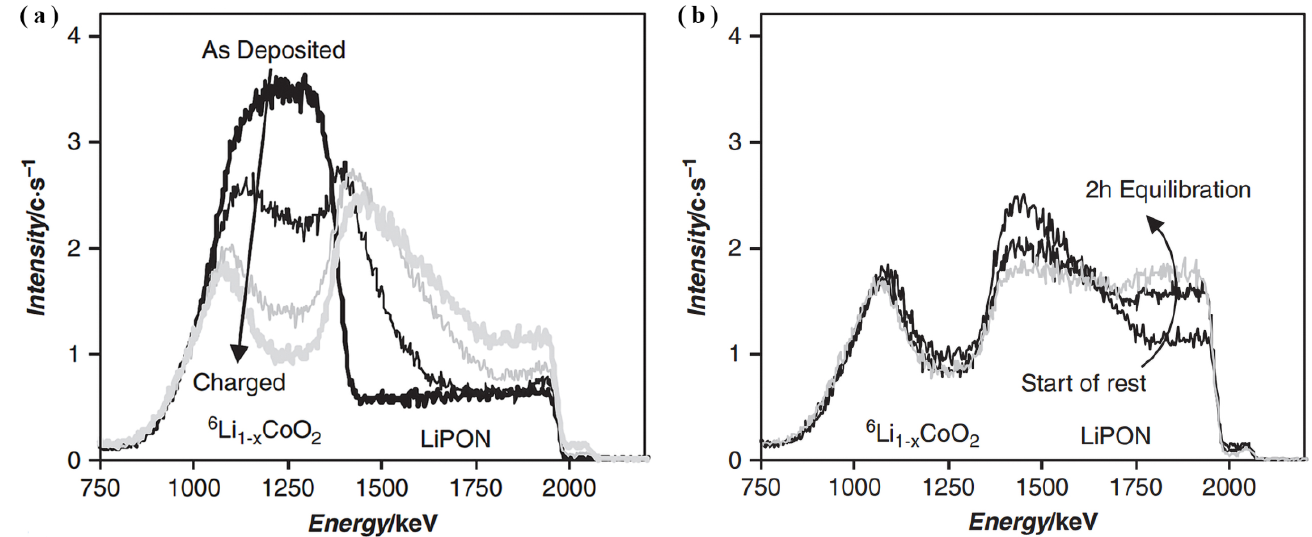
Figure 8. In situ NDP schemes of 6 LiCoO 2 /N-LiPON/Li battery at ( a ) various stages of charging and ( b ) equilibration in the charged state after 0, 1, and 2 h (adapted with permission from Ref. [37]. 2011 Wiley-VCH).